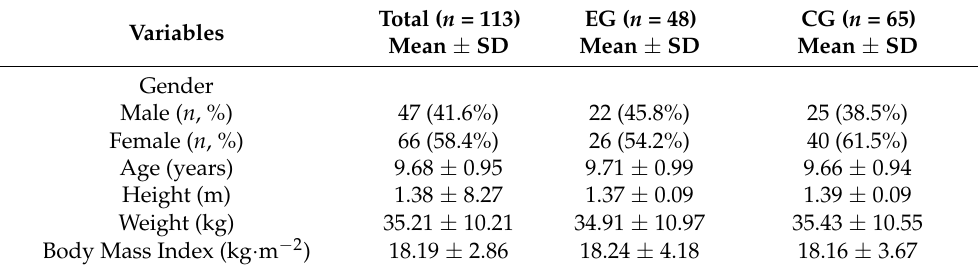
Table 1. General Characteristics of the Participants ( n = 113, boys = 47, girls = 66).